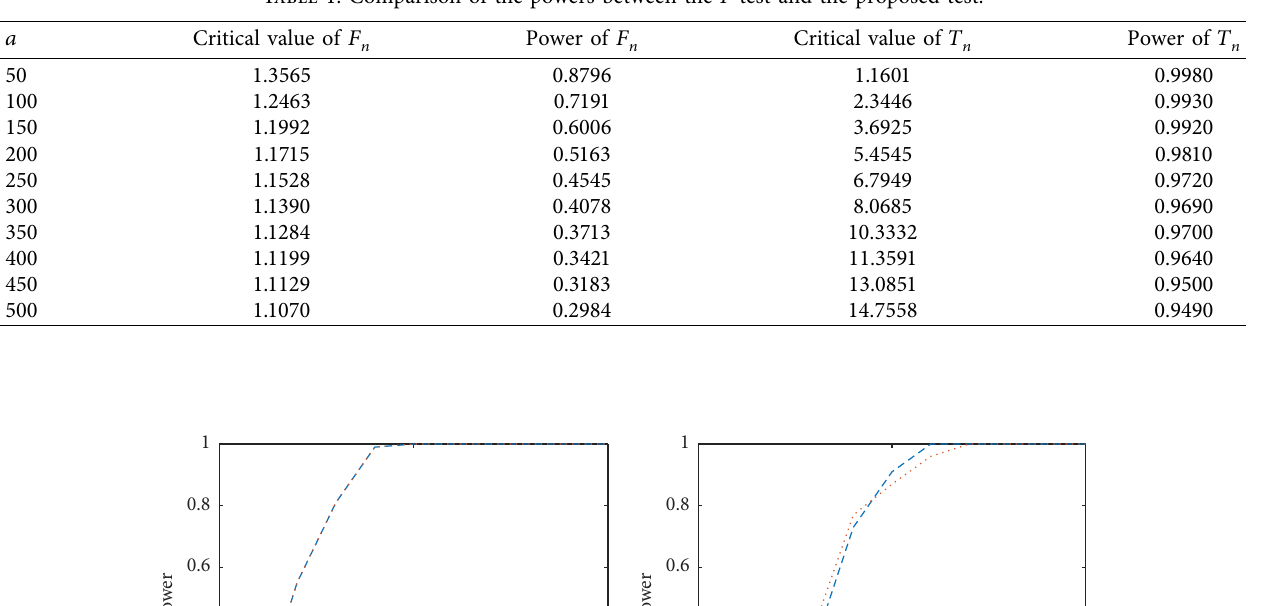
Table 1: Comparison of the powers between the F test and the proposed